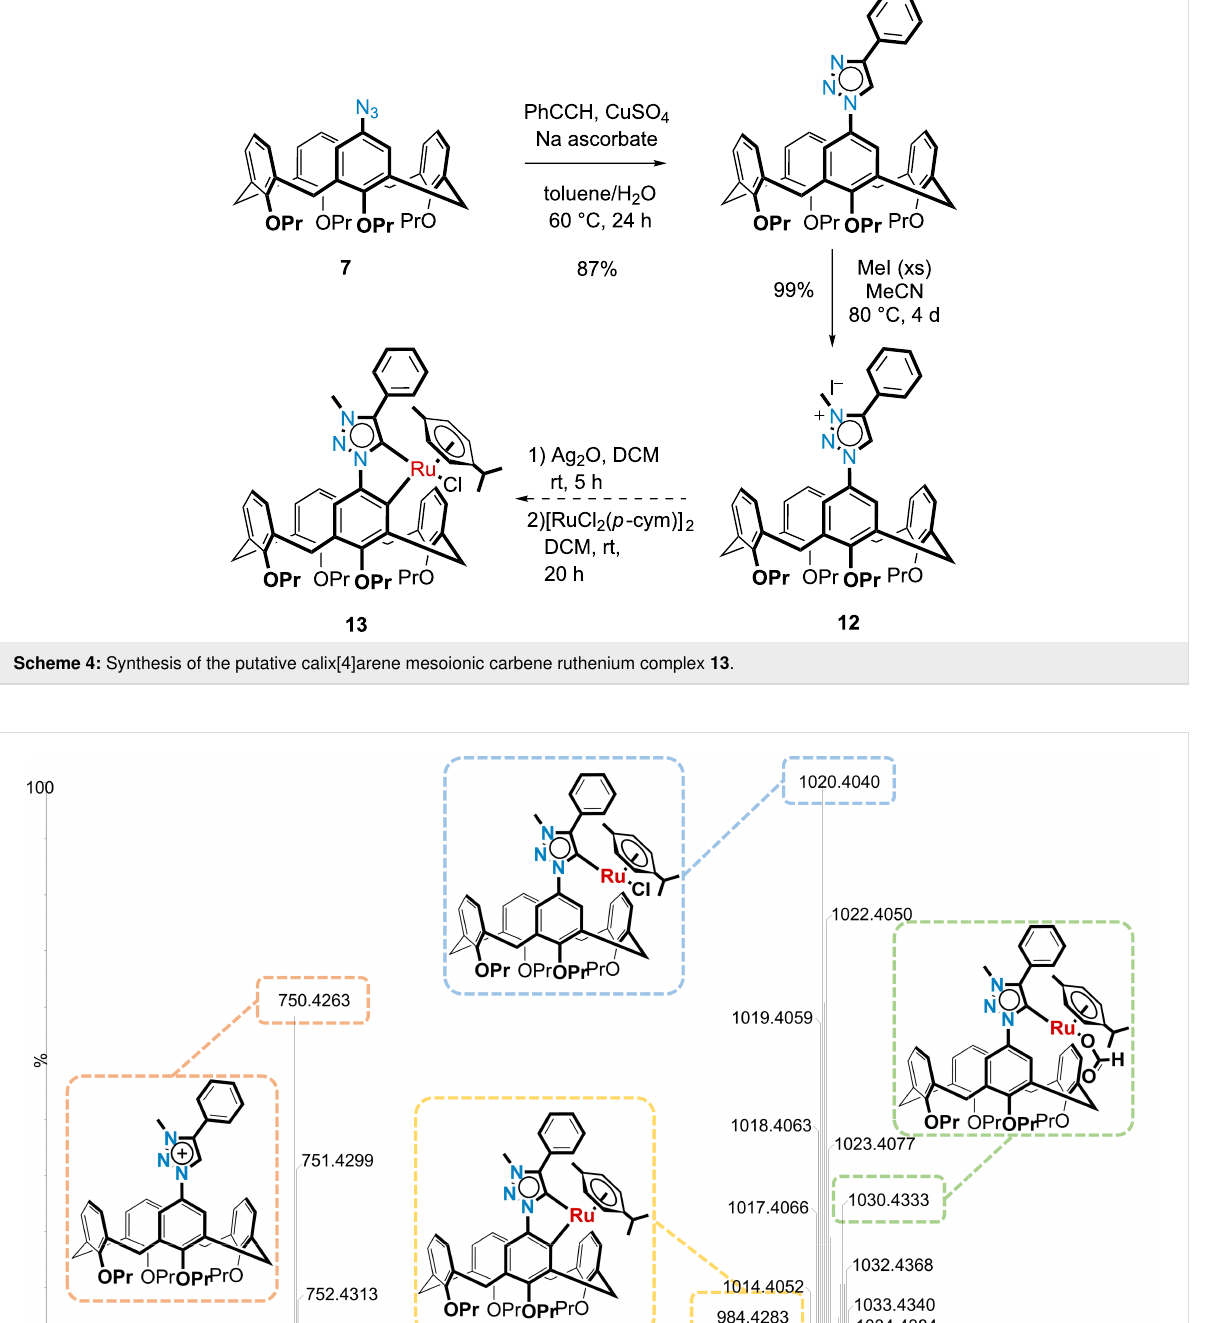
tion File 1 for a closer view of this). The major peak observed had a monoisotopic mass of 1020.4040 Da which fitted the pre- dicted value for [M + H] + of 1020.4020 Da ( Δ m i = 1.95 ppm) including the isotopic distribution pattern (Figure 4).